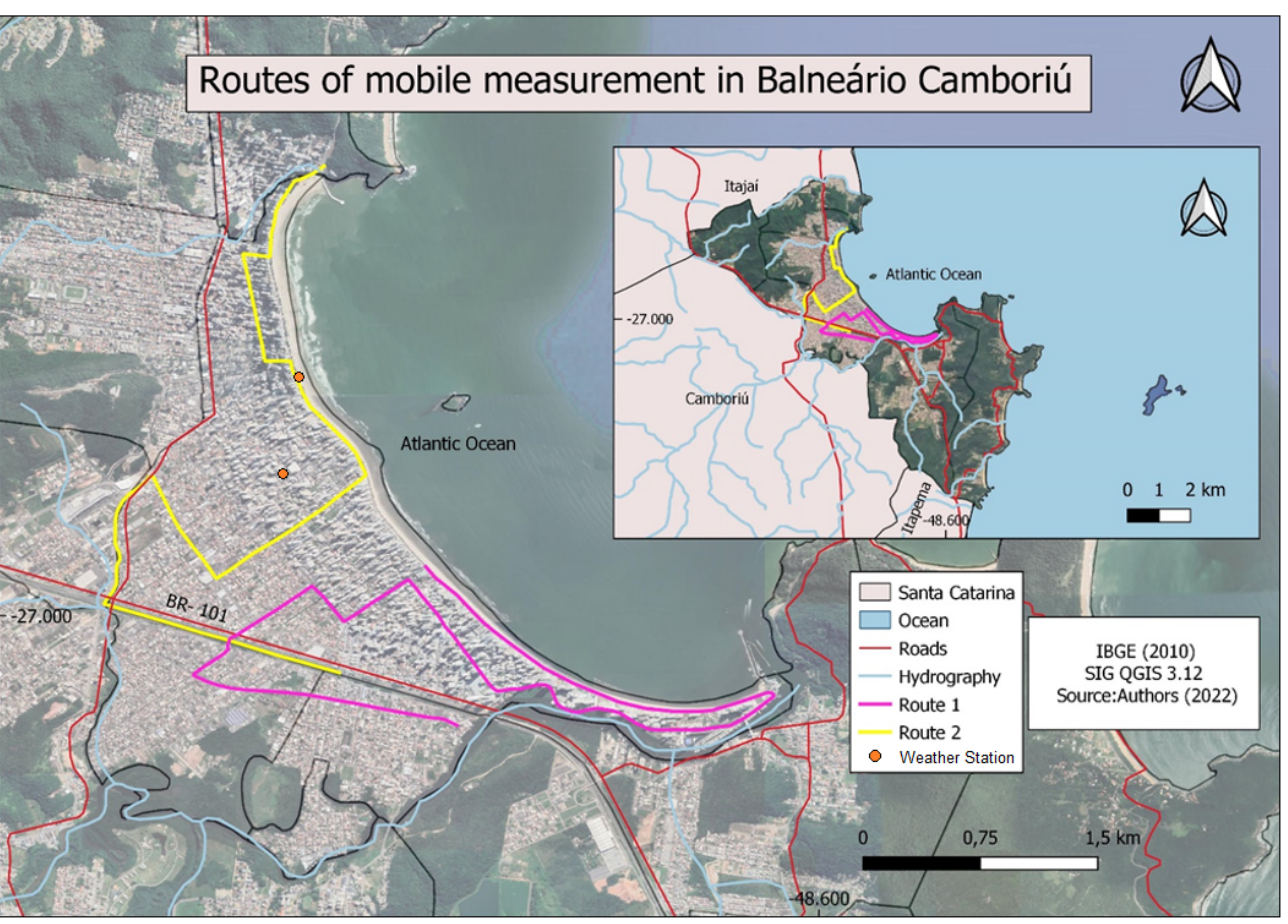
Figure 4. Map of mobile transects carried out in the urban area of Balneário Camboriú/SC, on